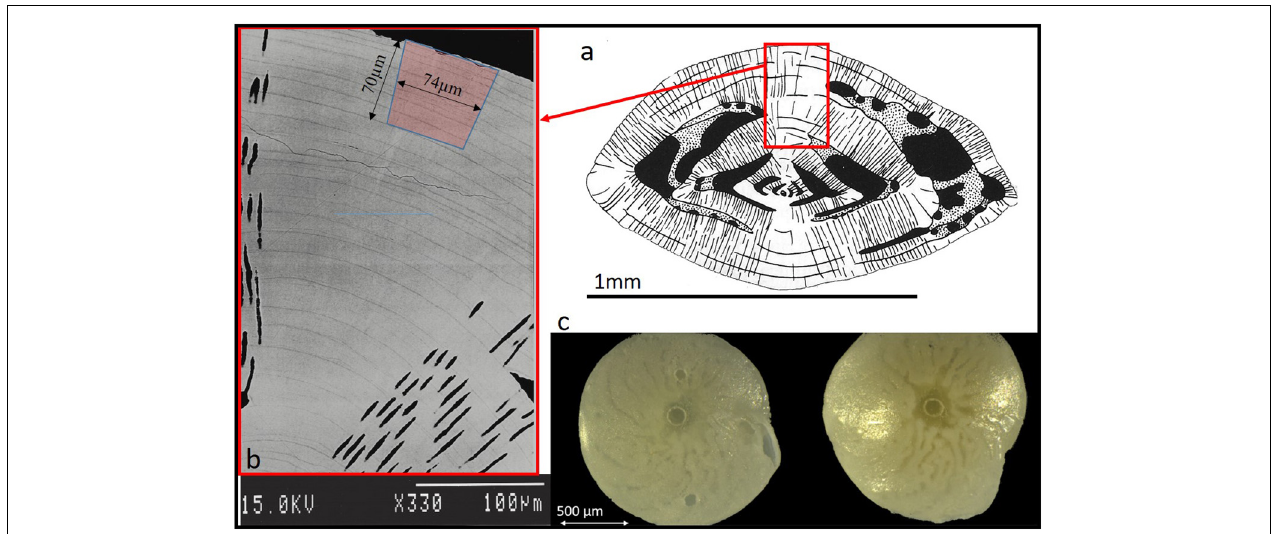
FIGURE 1 | (a) Schematic diagram of Amphistegina lobifera vertical cross section (Adapted from Reiss and Hottinger, 1984). The knob is an imperforated structure build like multi layers concentric dome. (b) Back scatter SEM image of a polished vertical section through the knob of A. lobifera (see Erez, 2003), note the thin dark layers representing ∼ weekly chamber growth lines. These dark layers are rich in Mg and K as well as other trace elements (see Figs below). The laser drilling marked in red is roughly 70 mm deep. (c) Images of the actual ablation hole in the knob of A. lessonii (left) and A. lobifera (right).